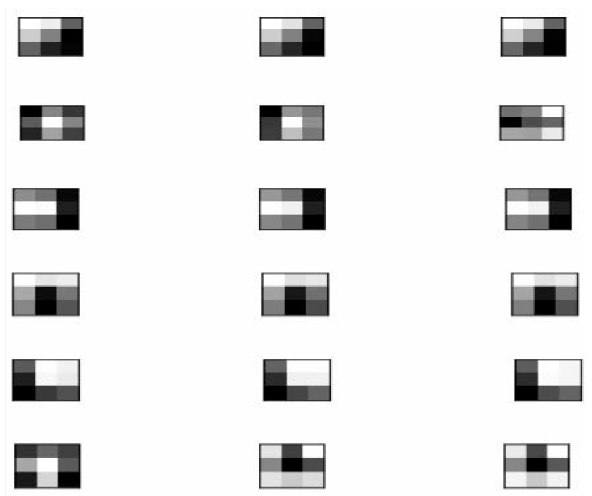
Figure 9. Image features of the first 6 filters in the first convolutional layer of the VGG-19